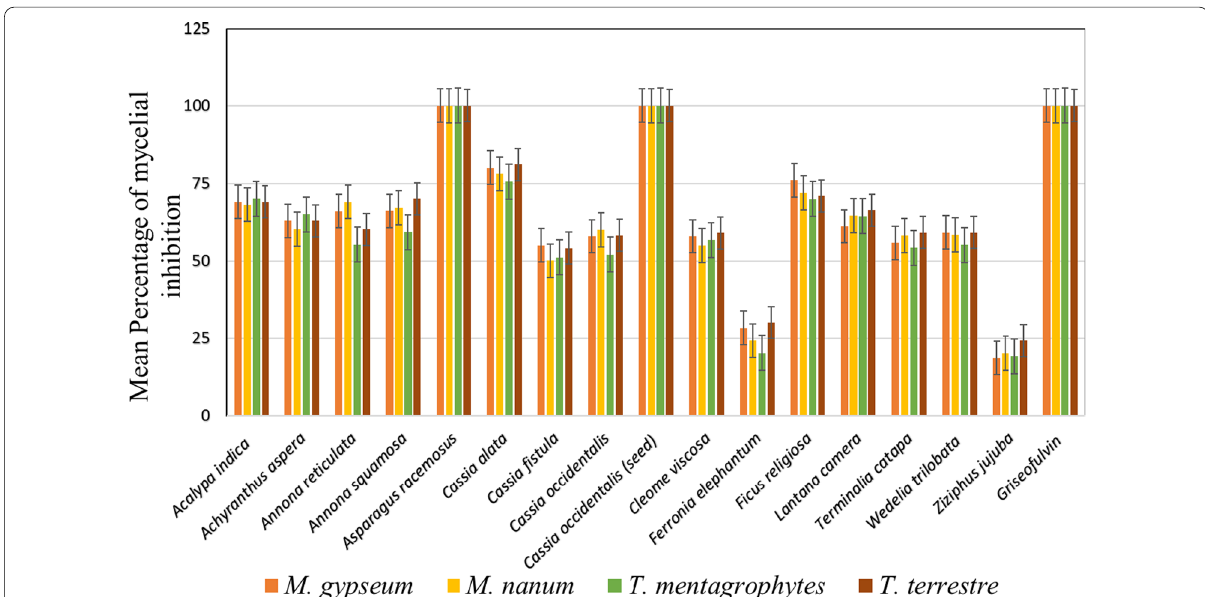
standard deviation. **Significant at ±